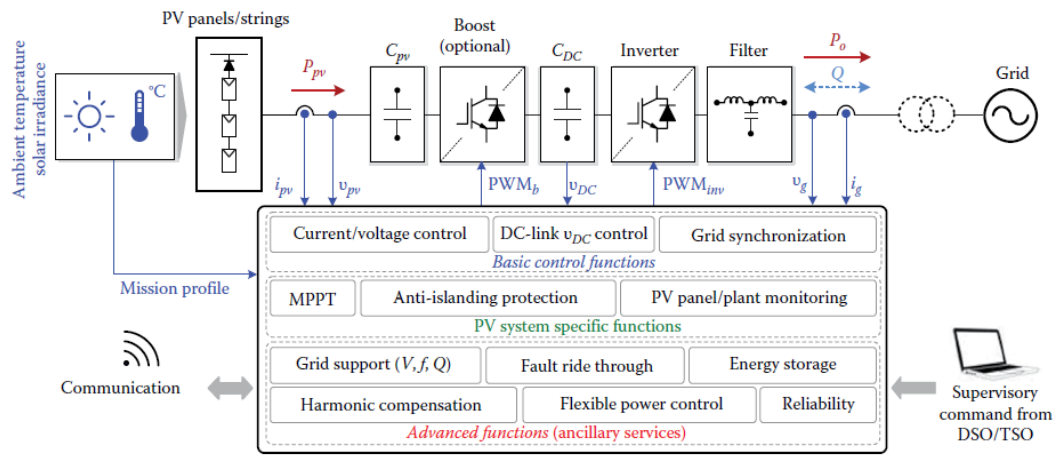
Figure 23. Generic control structure for Single phase grid-connected system [29,101].